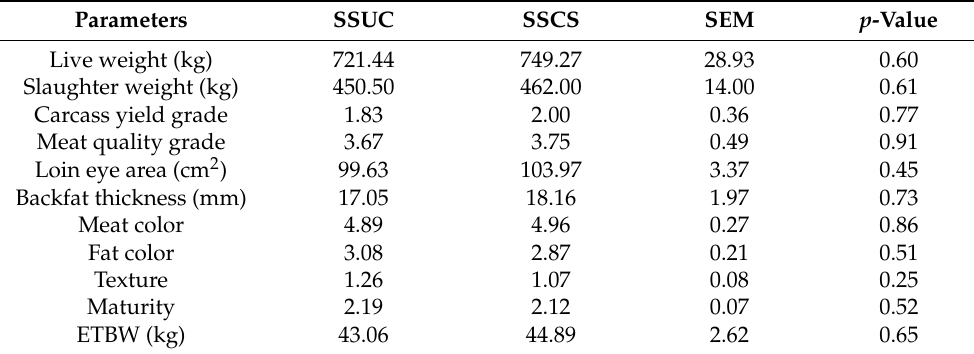
Table 1. Effect of slaughtering with or without state of consciousness on carcass characteristics in Korean Hanwoo Finishing